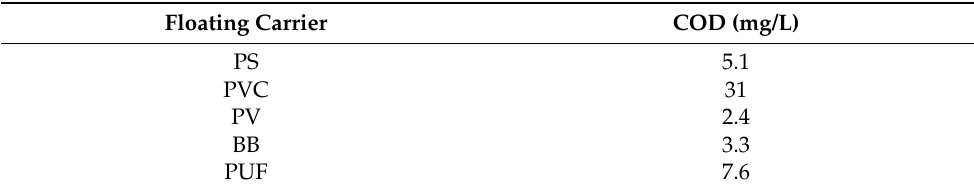
Table 1. COD values for examined type of floating carrier.